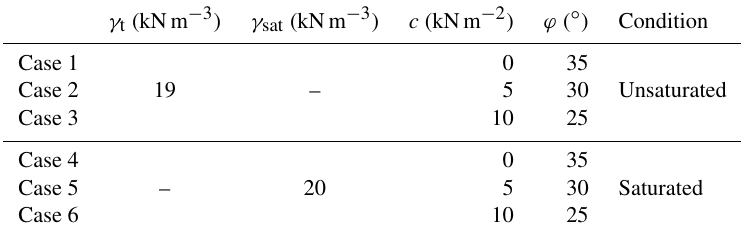
Table 1. Ground conditions